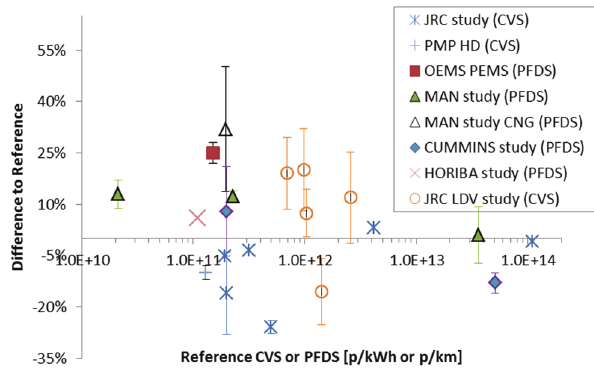
Fig. 7. Differences of SPN23 systems at the tailpipe from SPN23 systems at the CVS or PFDS. Each point is an engine with at least 3 tests. Error bars show one standard deviation of the